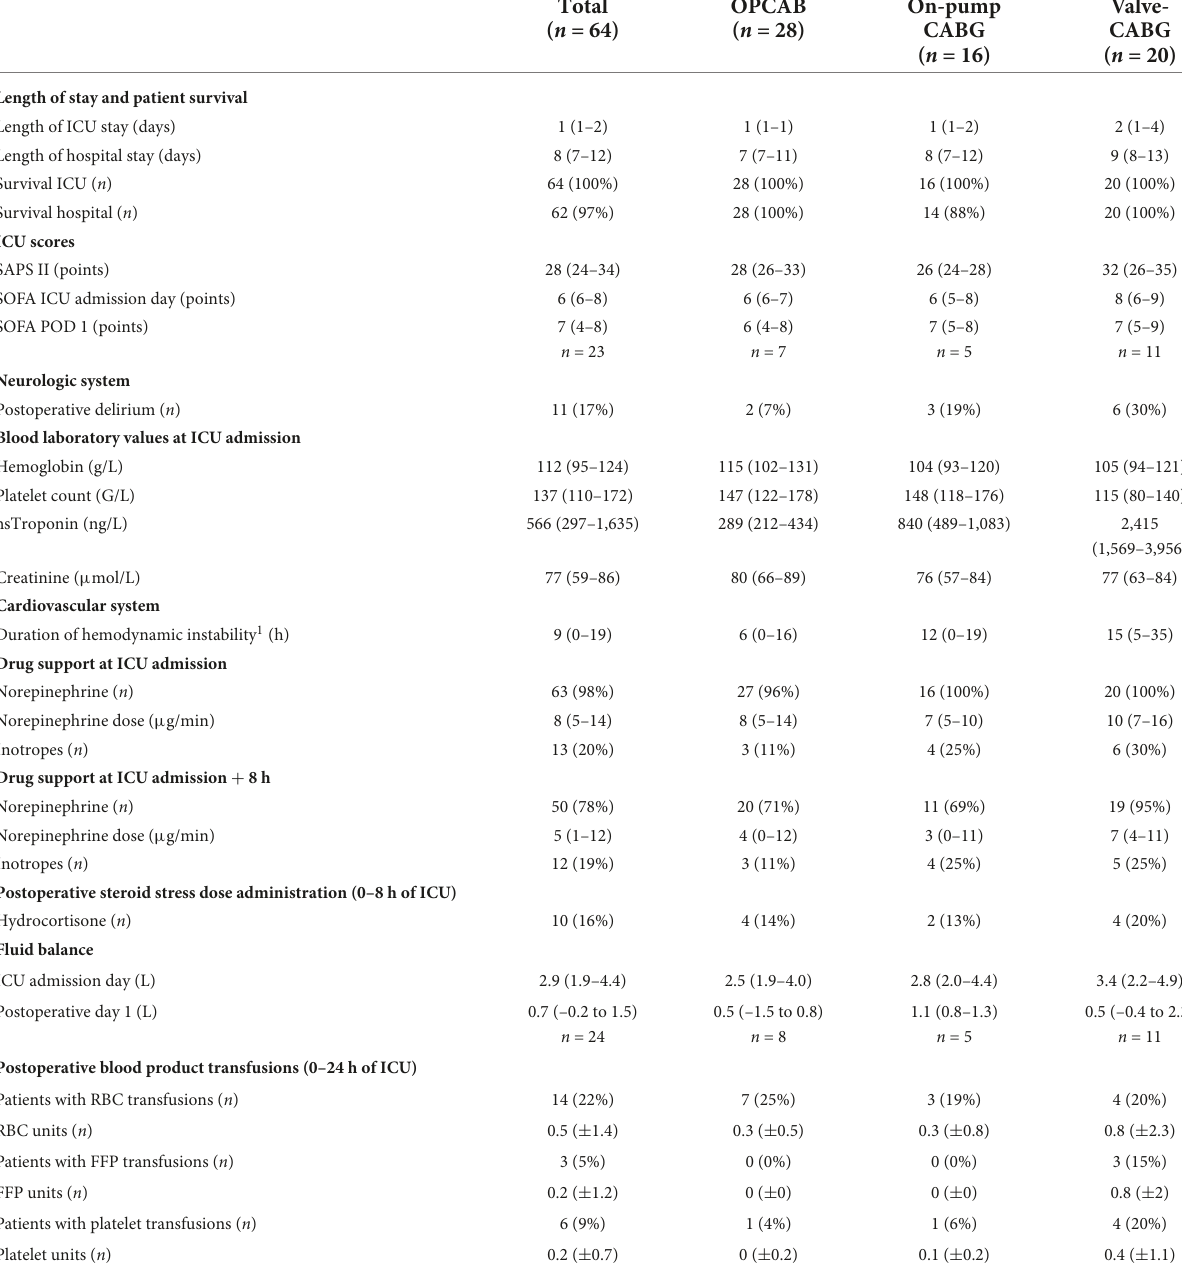
TABLE 2 Intensive care unit parameters and patient